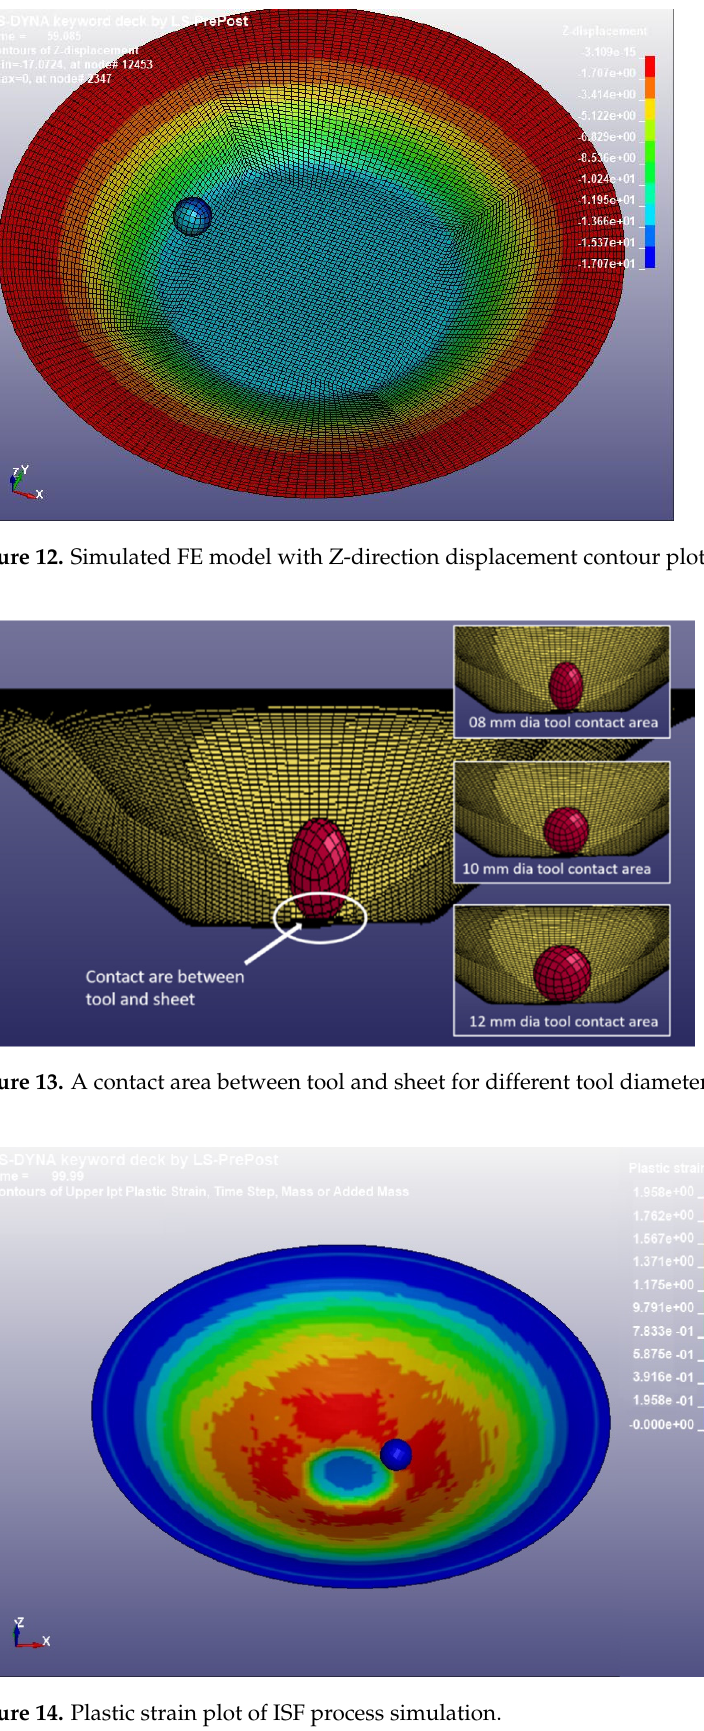
Figure 14. Plastic strain plot of ISF process simulation